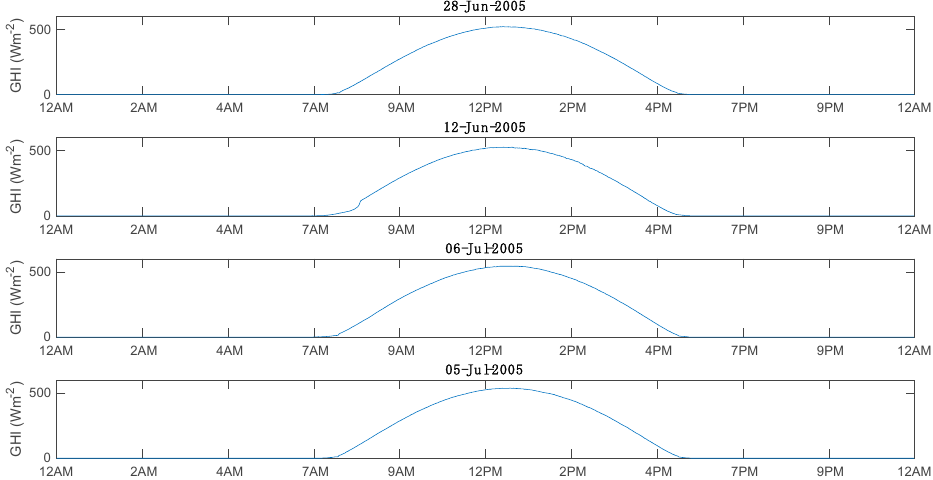
Figure 2. Clear test days as described in Table 1. The clear cases include days on 28 June 2005, 12 June 2005, 6 July 2005, and 5 July 2005 arranged from top to bottom.